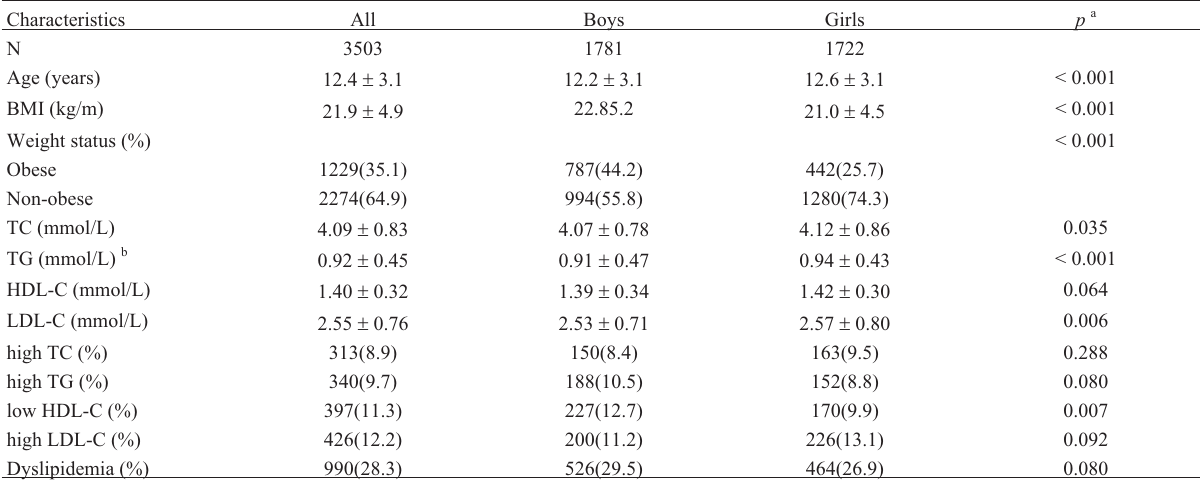
Table 1 - Characteristics of the study population.